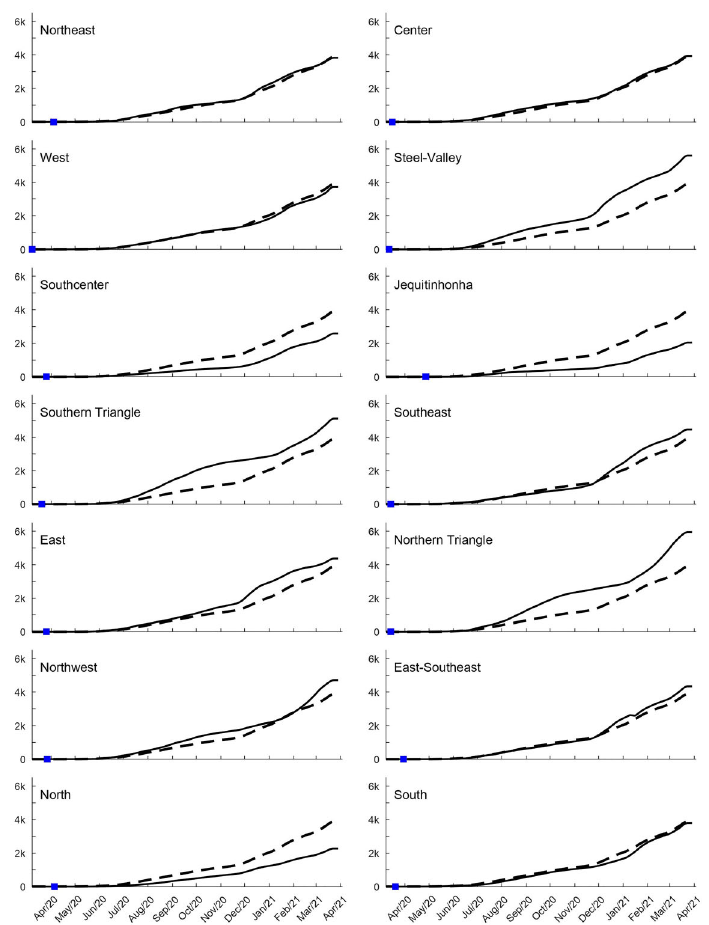
Figure 4. COVID-19 prevalence (per 100k inhabitants) for the 14 Minas Gerais macro-regions (full lines) contrasted with the whole state (segmented lines). The fi rst con fi rmed case within each macro-regions is shown with a blue square mark.